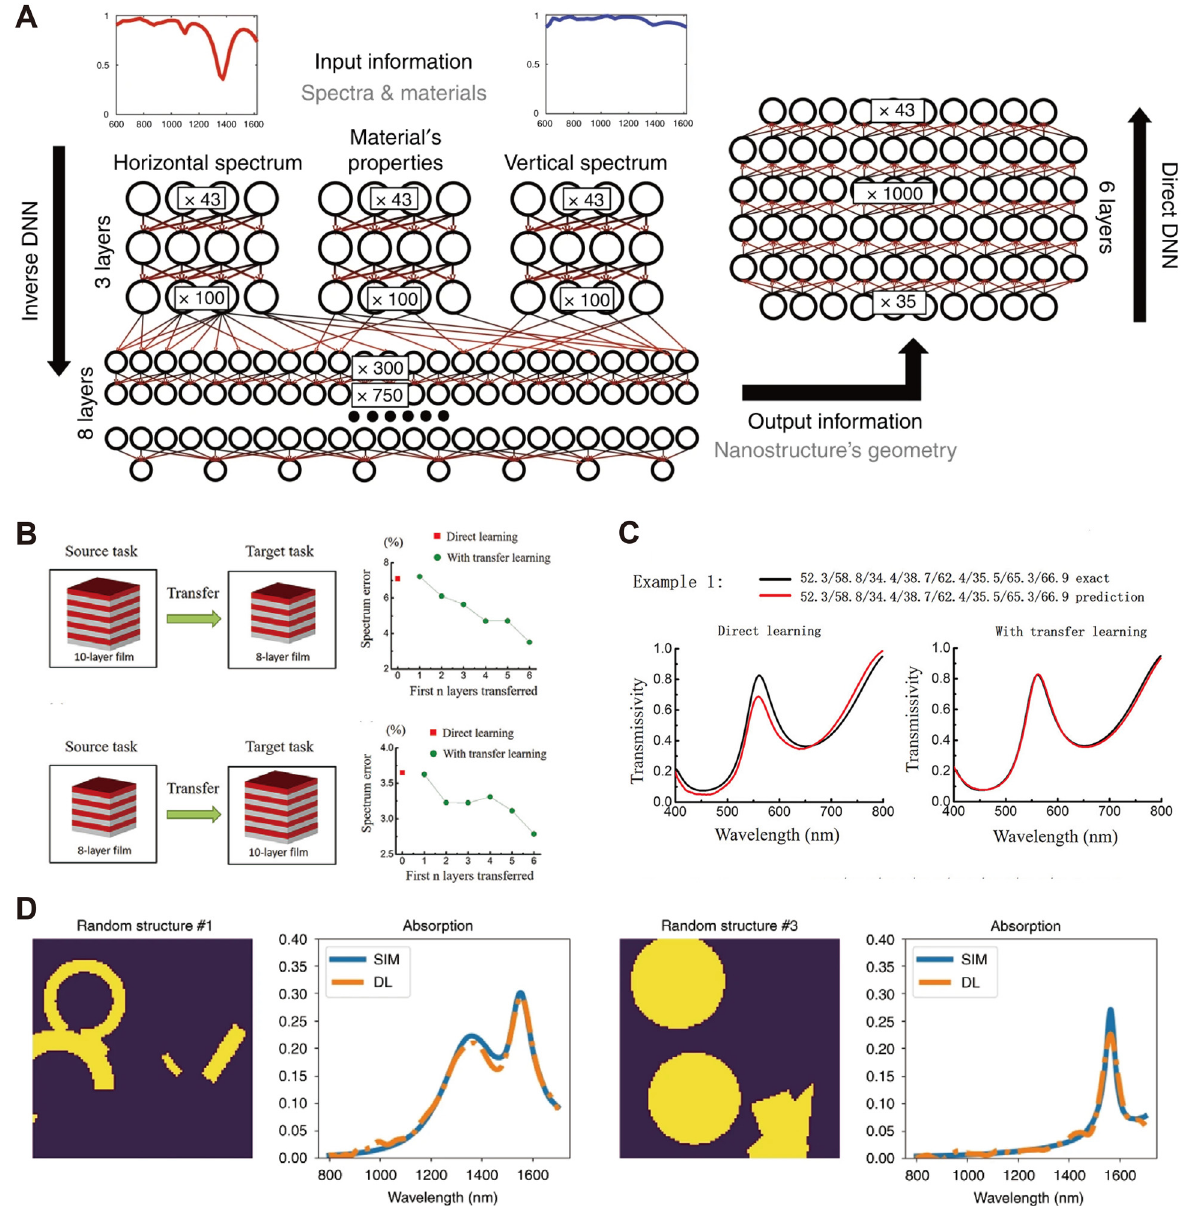
Figure 4: Discriminative deep learning model for spectra predicting and design parameter retrieval (A) bidirectional network for plasmonic nanostructure design. Left: geometry predicting network with TE&TM spectra and material properties as input. Right: spectra predicting network, concatenated to the first network in a cascaded structure. Adapted from [92]. (B) Knowledge transfer between the design of 8-layered and 10-layered transmissive films. As the shared network layers keep increasing, both transfer schemes (8-layered to 10-layered and the inverse) show better prediction precision compared with direct training. (C) Example of predicted spectra compared to real spectra from the 8-to-10-layer transfer learning tasks. Left: direct learning. Right: transfer learning. (B) and (C) are adapted from [89]. (D) Results of the discriminative design on the plasmonic silver absorber. The device structure is encoded as 2D images, with absorption spectra predicted by the RNN and FCN layers. Adapted from